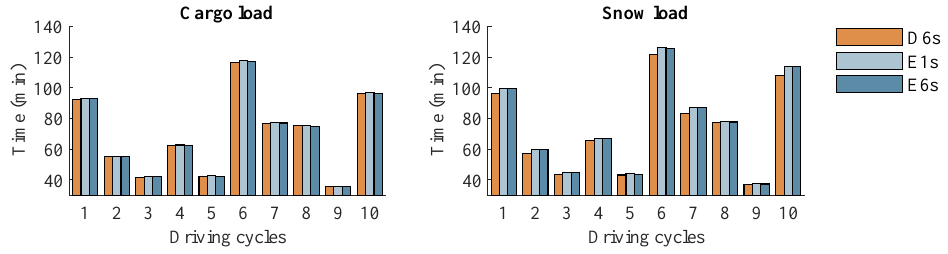
Figure 13. Total driving duration for each simulation in both load